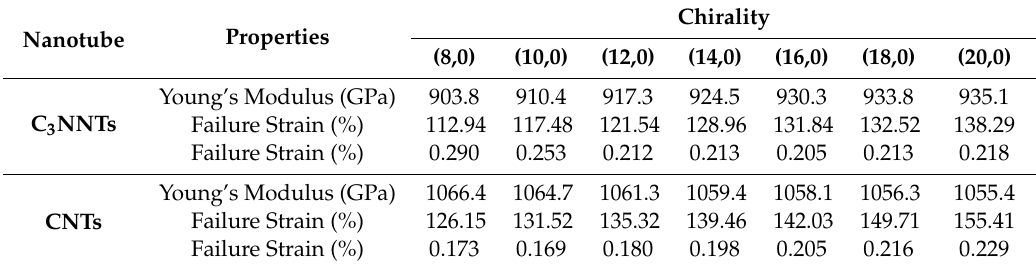
Table 3. Same as Table 2, but for zigzag SWC 3 NNTs and